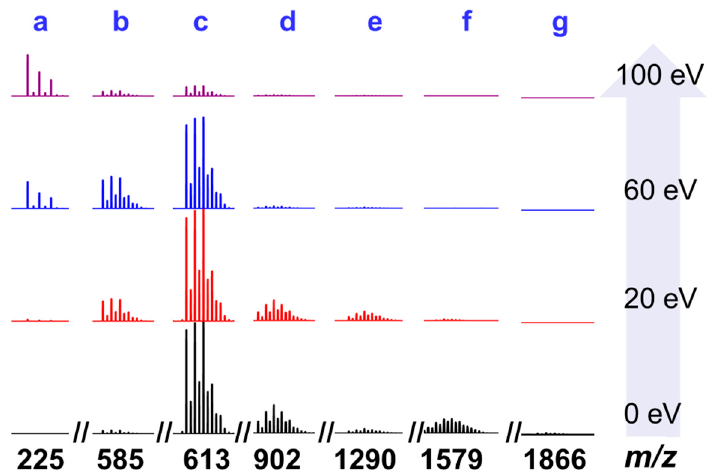
Figure 2. High resolution electrospray mass spectrometry (HRESI-MS) fragment (cationic mode) of cluster Zn6 at different ion source energies (0~100 eV).